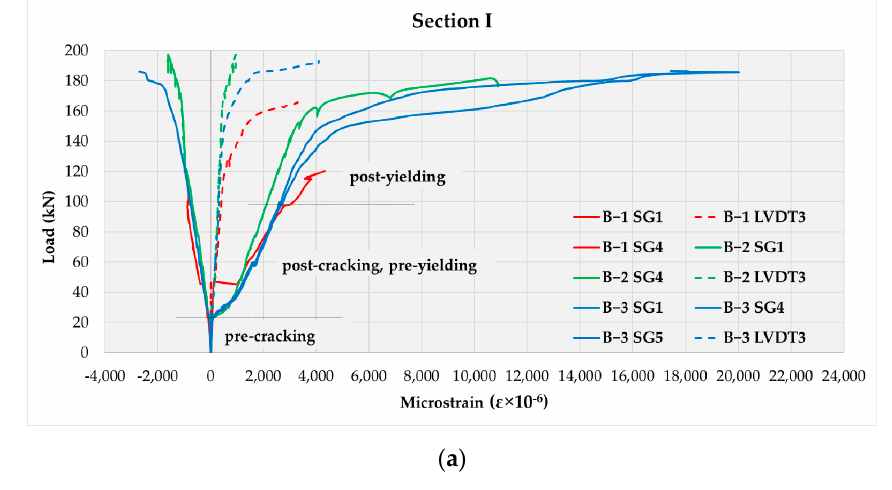
Figure 4. Load vs. deflection curves in Section I—left span and Section II—right span for tested Beams B − 1, B − 2 and B −